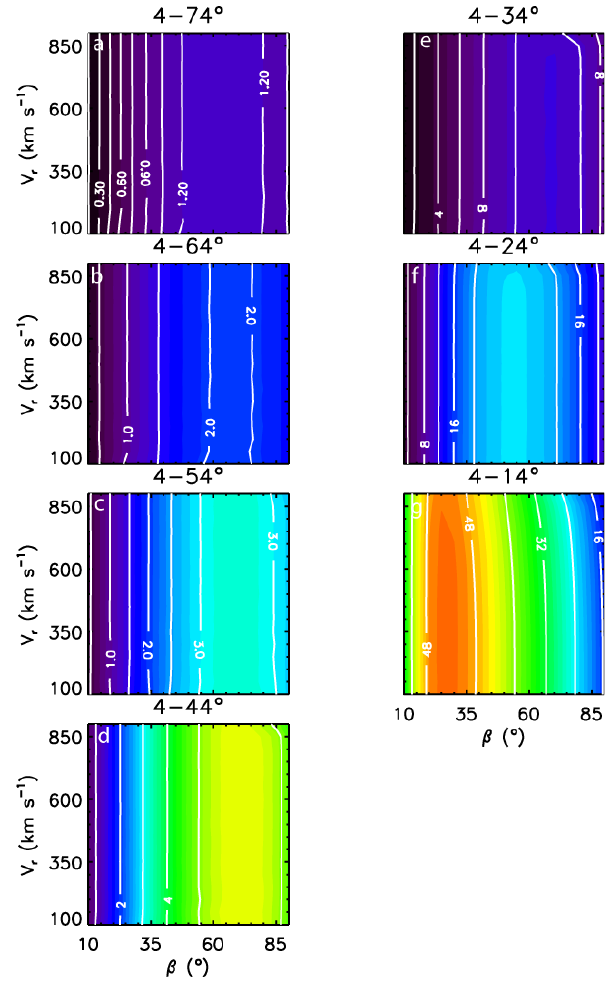
Fig. 6. Contour plots of the mean absolute error in V r as a function of V r and β . Each panel is derived from fitting tracks over the elongation range given. The mean absolute error is colour coded, with black (red) corresponding to small (large) values, and values are also marked on the overlaid contours. Note that the panels in the left hand column are on a common colour scale, and those on the right are on a common but different colour scale.